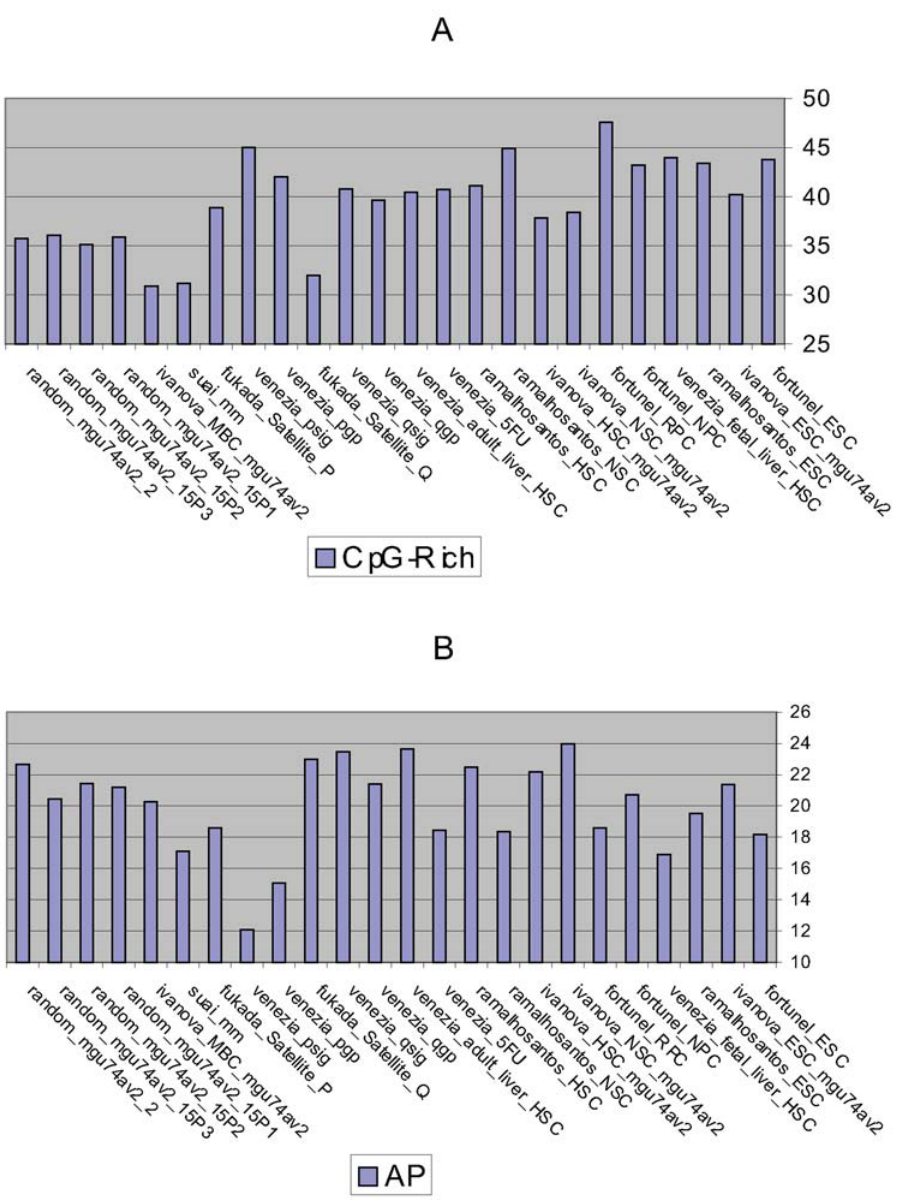
Figure 4. The percentages of the genes classed according to the promoter type. The promoters are characterised using the Bioinformatics methods outlined in part 3 ( Fig 1 ). The y-axis reports the percentage of genes using ( A ) CpG-rich promoters and ( B ) APs whilst the x-axis reports the data sets analysed ( Tables 1 , 2 ).